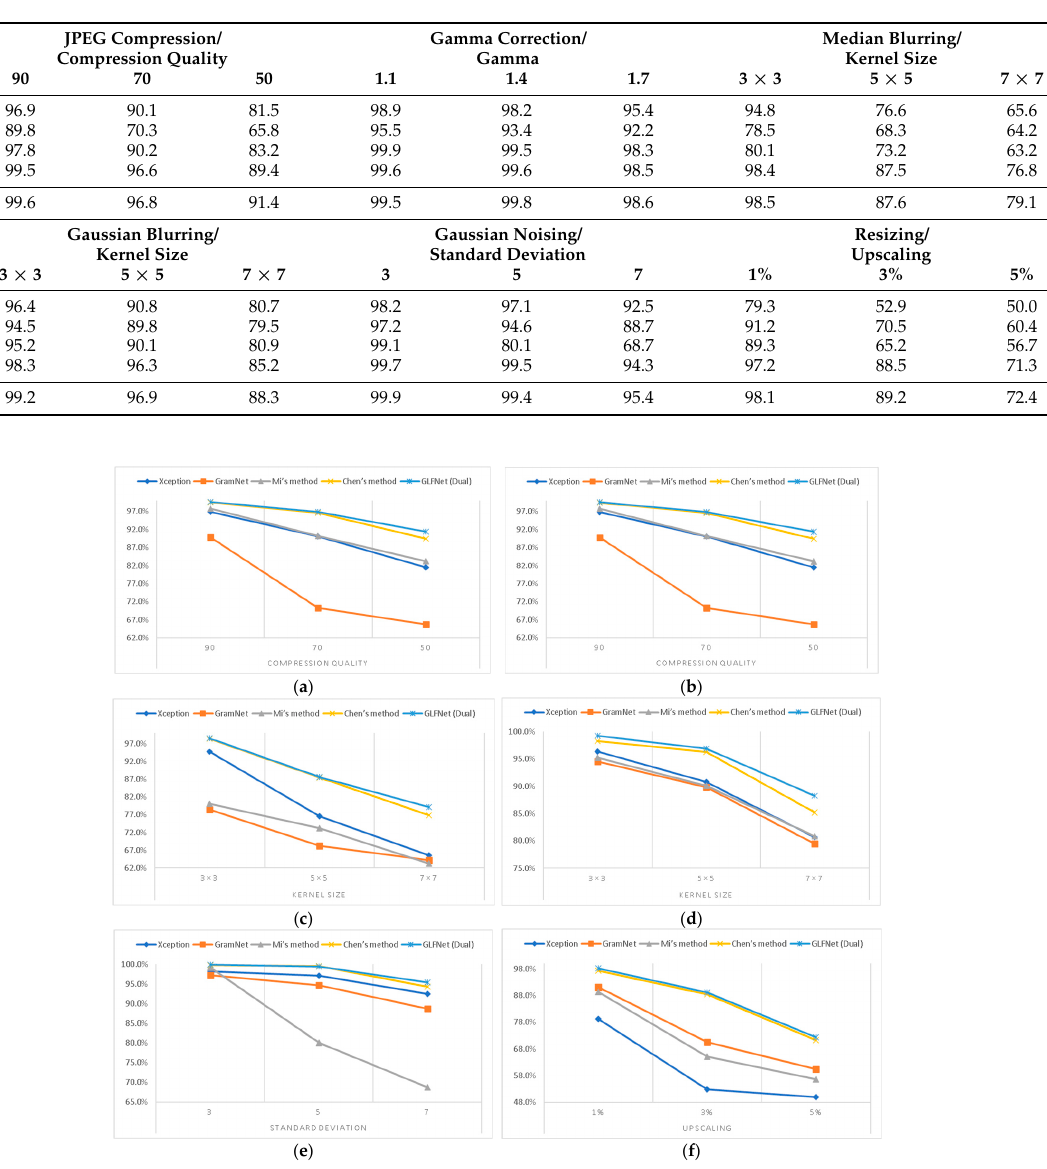
Table 9. Comparisonofclassificationaccuracy(%)inpost-processingoperationswithstate-of-the-artmethods.